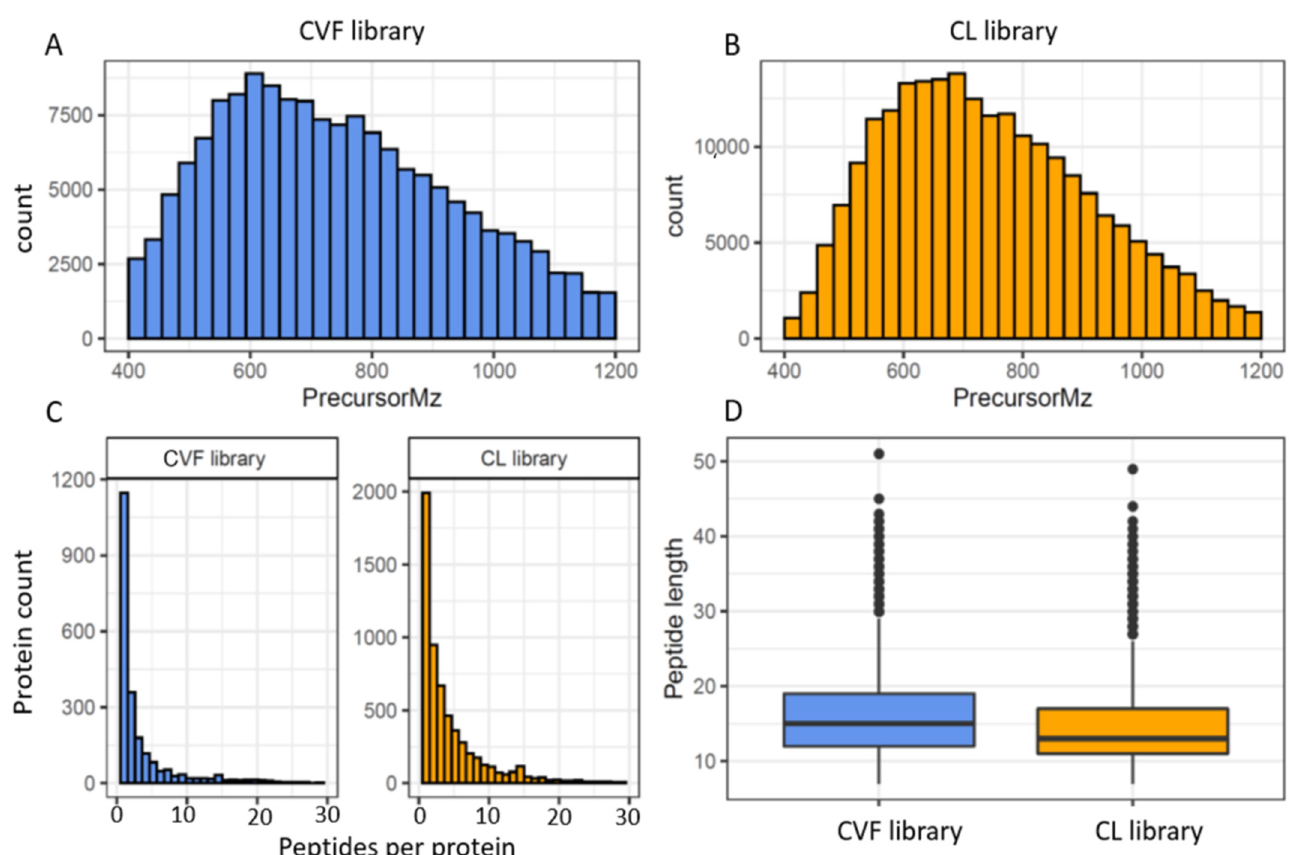
Figure 3. Overview of the cervico-vaginal fluid (CVF) and the EC cell-line (CL) based spectral library properties ( A ) histogram of the precursor ions m/z distribution of the CVF library ( B ) histogram of the precursor ions m/z distribution of the CL library ( C ) histogram of protein identifications based on the number of peptides per protein for both libraries ( D ) histogram of the peptide length distribution for both libraries.